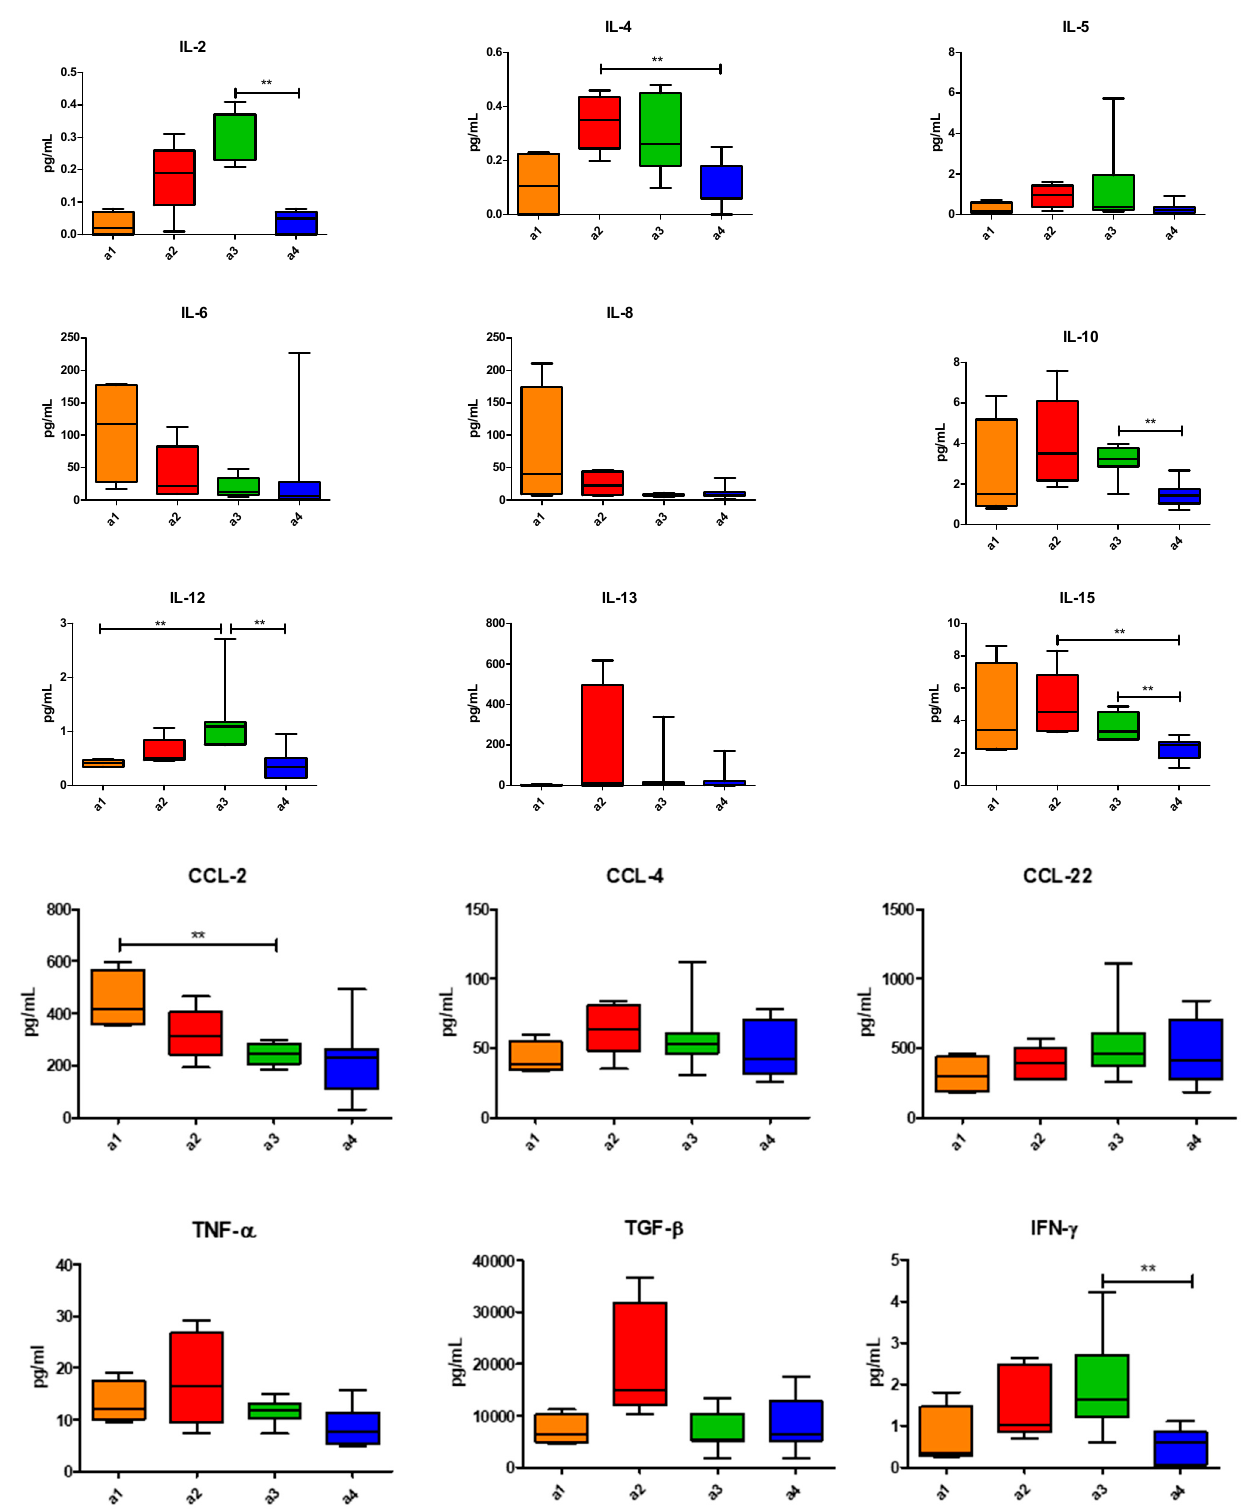
Figure 6. Distributions of cytokines among four areas: orange bars for area 1 (4 pts), red bars for area 2 (5 pts), green bars for area 3 (7 pts) and blue bars for area 4 (7 pts). Concentrations are express in pg/mL. Only p values corrected for multiplicity are shown. ** p ≤ 0.01.